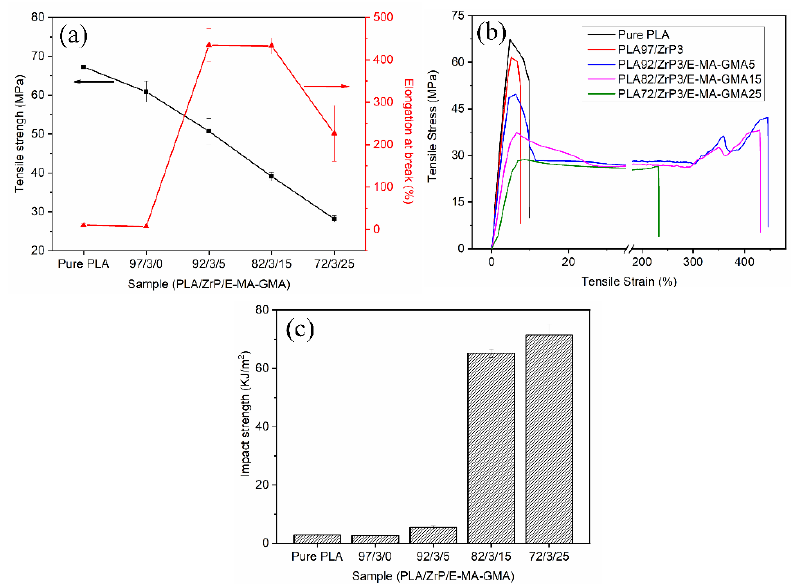
Figure 8. Mechanical properties of PLA, PLA/ZrP, and PLA/ZrP/E − MA − GMA nanocomposites: ( a ) tensile strength and elongation at break, ( b ) stress–strain curves, and ( c ) impact strength. The reason for the PLA/ZrP nanocomposite’s transference from a brittle to ductile Table 4. The detailed data of mechanical properties for PLA, PLA/ZrP, and PLA/ZrP/E-MA-GMA